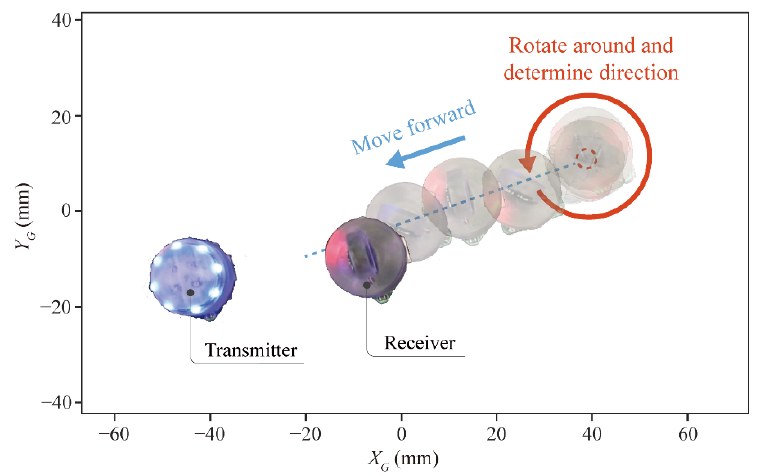
Figure 10. Process of Receiver approaching Transmitter. Step 1: Record the maximum light intensity during the entire rotation. Receiver rotated around and detected all blue light intensity at 360 ◦ . Only the higher intensity will be recorded during rotating compared with the previous signal